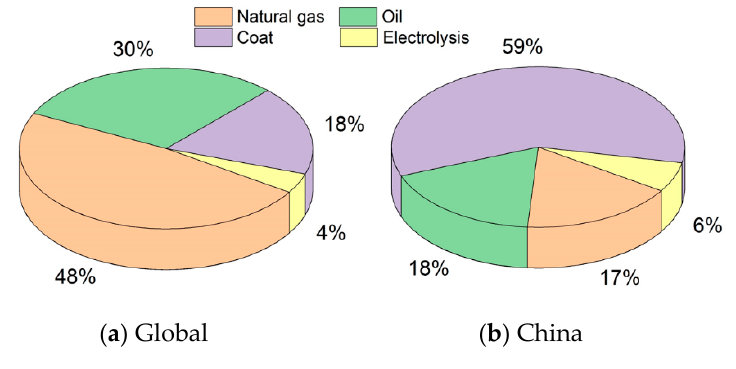
Figure 3. Sources of hydrogen in 2018.